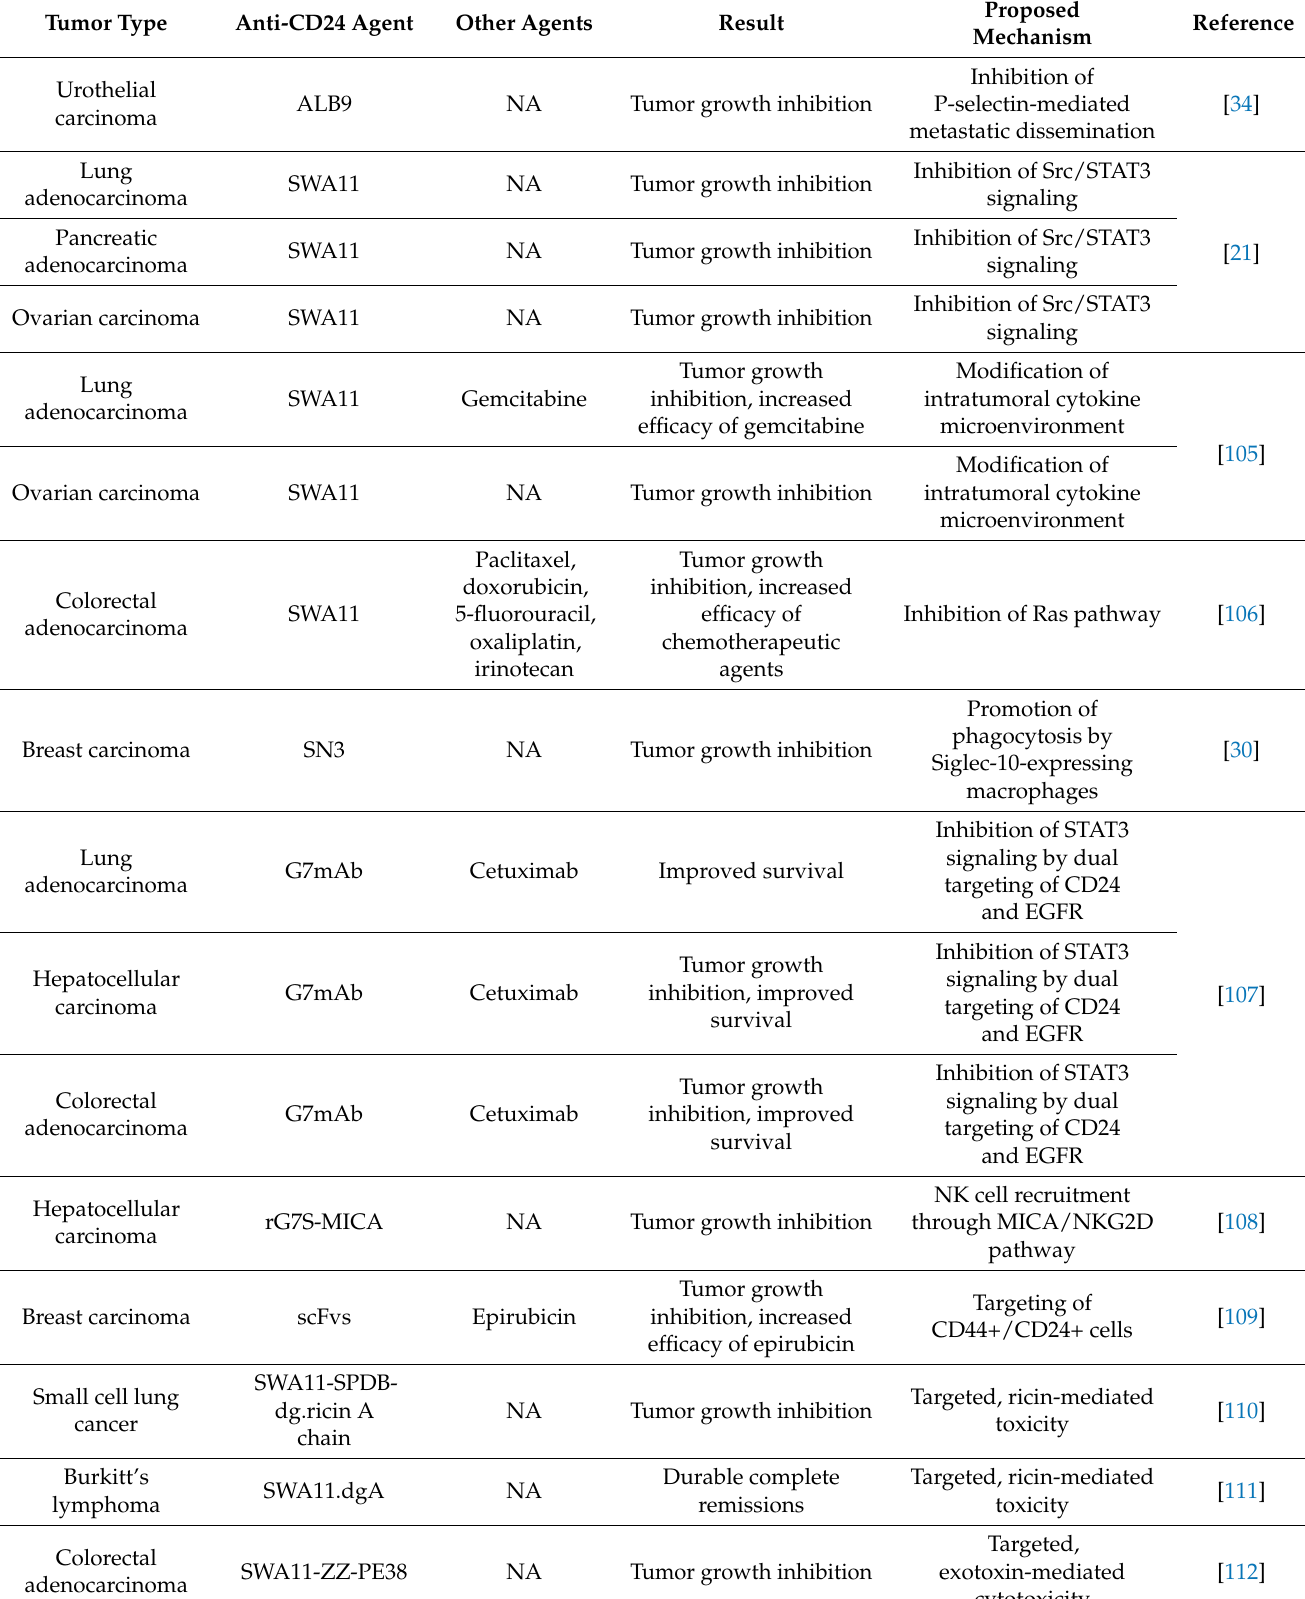
Table 3. Preclinical studies in vivo with agents that target